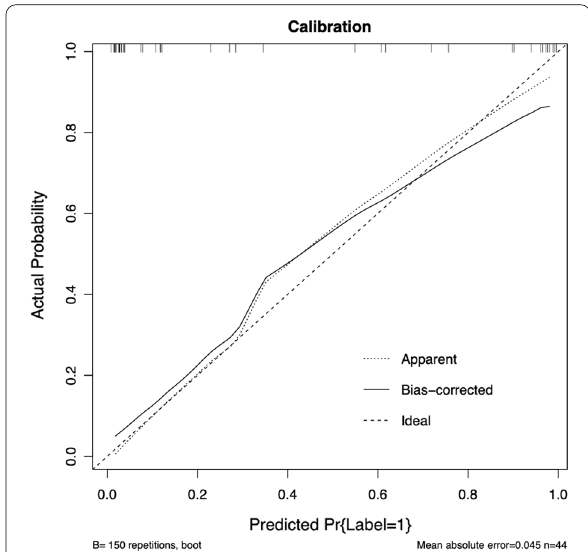
Fig. 5 Calibration curve of the nomogram. The Hosmer–Lemeshow test yielded a nonsignificant statistic ( p 0.837). Calibration curves = describe the model’s calibration in terms of agreement between the predicted probability of EMVI and observed positive proportion of EMVI. The dashed line named Ideal presents perfect performance, the other dashed line named Apparent presents the actual performance of the nomogram, and the solid line named Bias-corrected presents the actual performance of the nomogram after